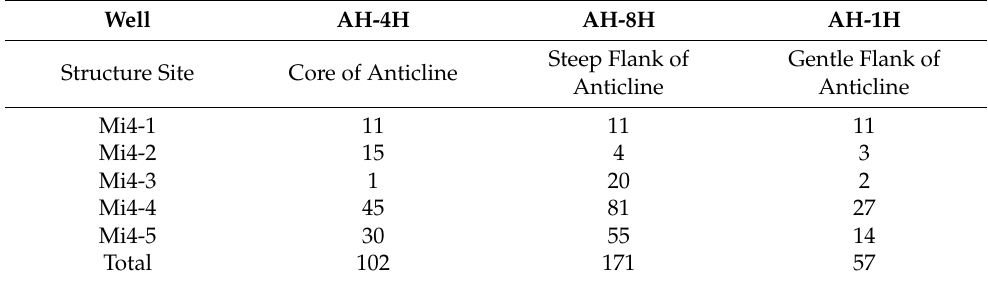
Table 2. The number of stylolites in the Mi4 member in Ah